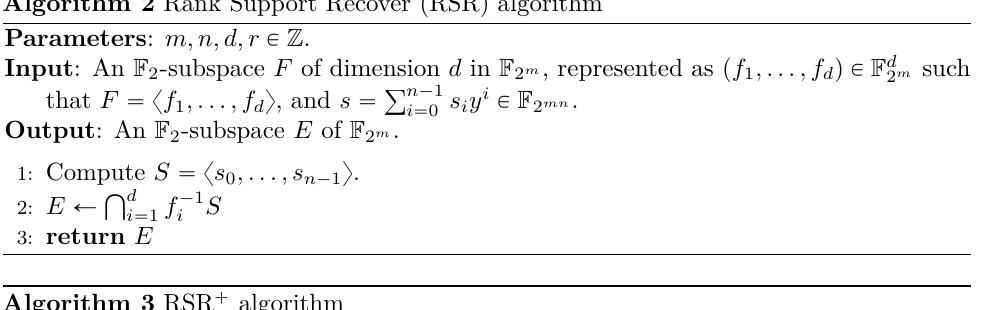
Algorithm 2 Rank Support Recover (RSR) algorithm